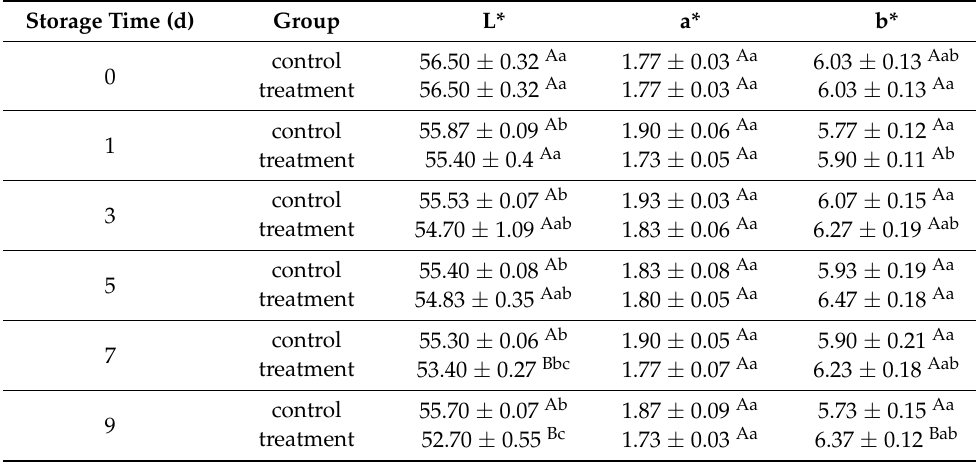
Table 1. Changes in the color of Trachinotus ovatus during refrigerator storage. Storage Time (d)